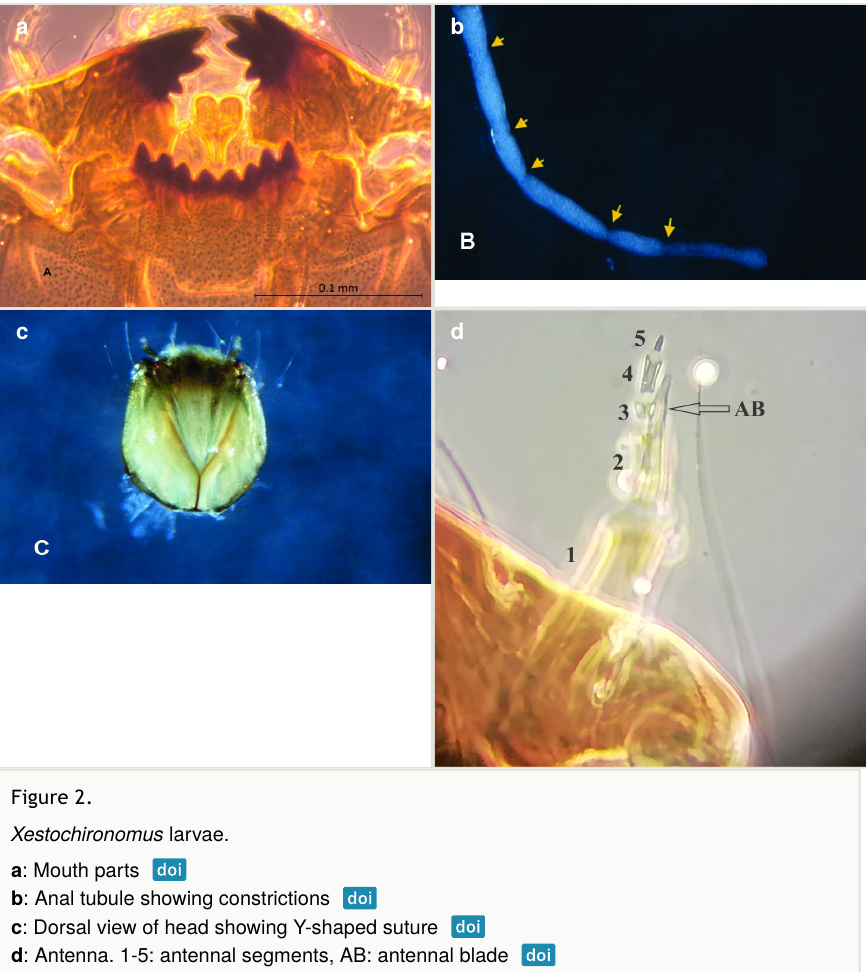
Figure 2. Xestochironomus